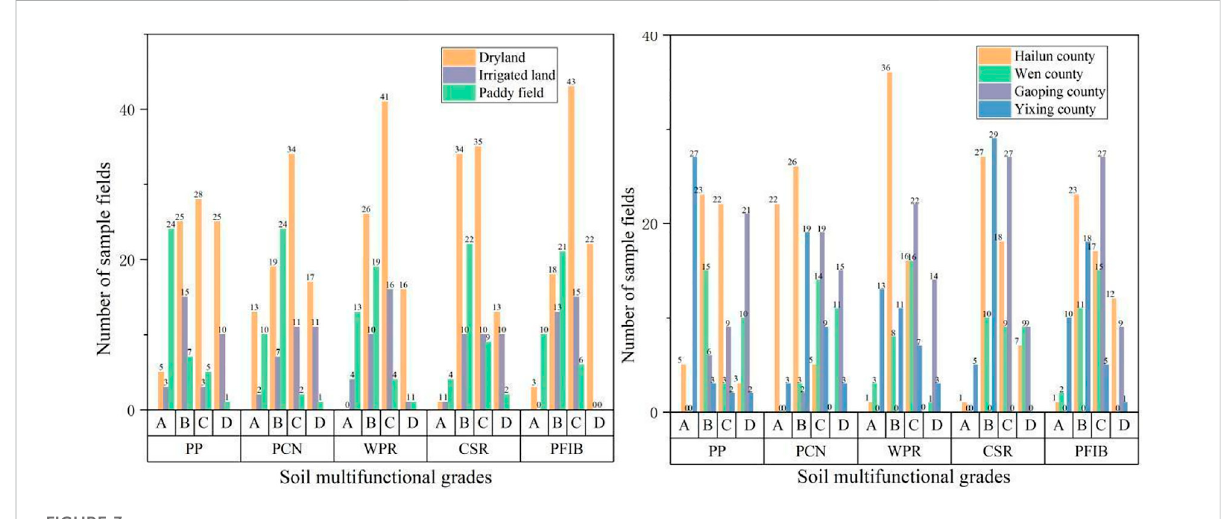
FIGURE 3 Soil multifunctional supply capacity in different land types and